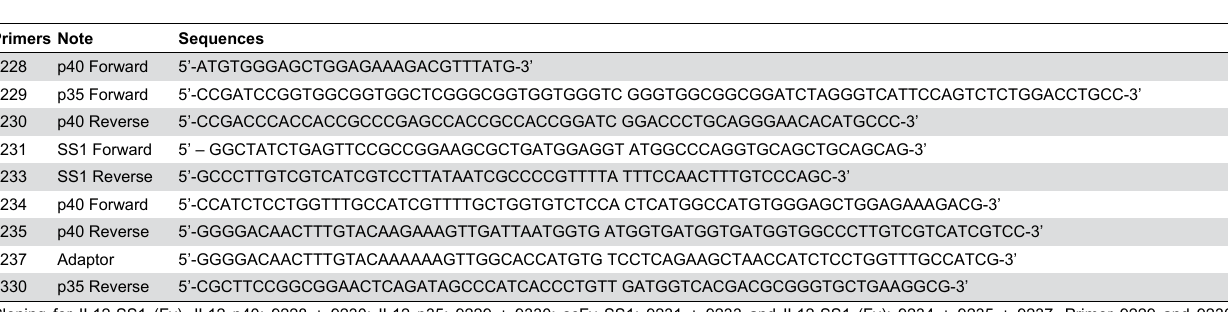
Table 1. Primers used for cloning of IL12-SS1